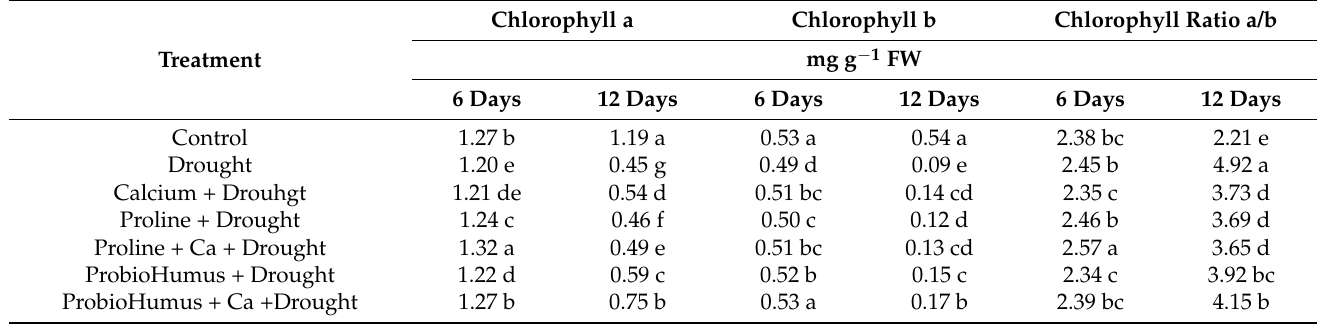
Table 2. Effect of stress ‐ protecting compounds on chlorophyll content of winter wheat seedlings.